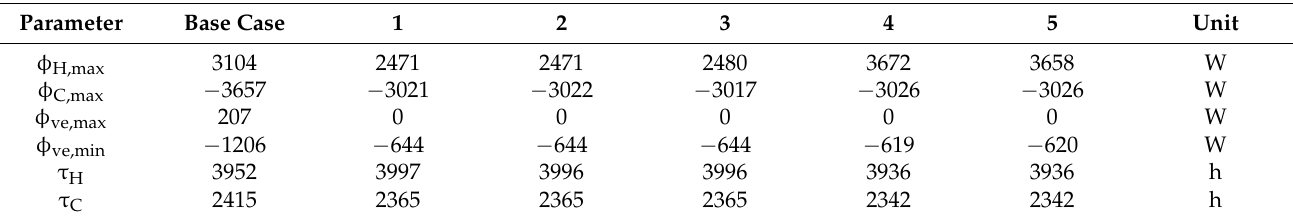
Table 3. Maximum hourly heating and cooling